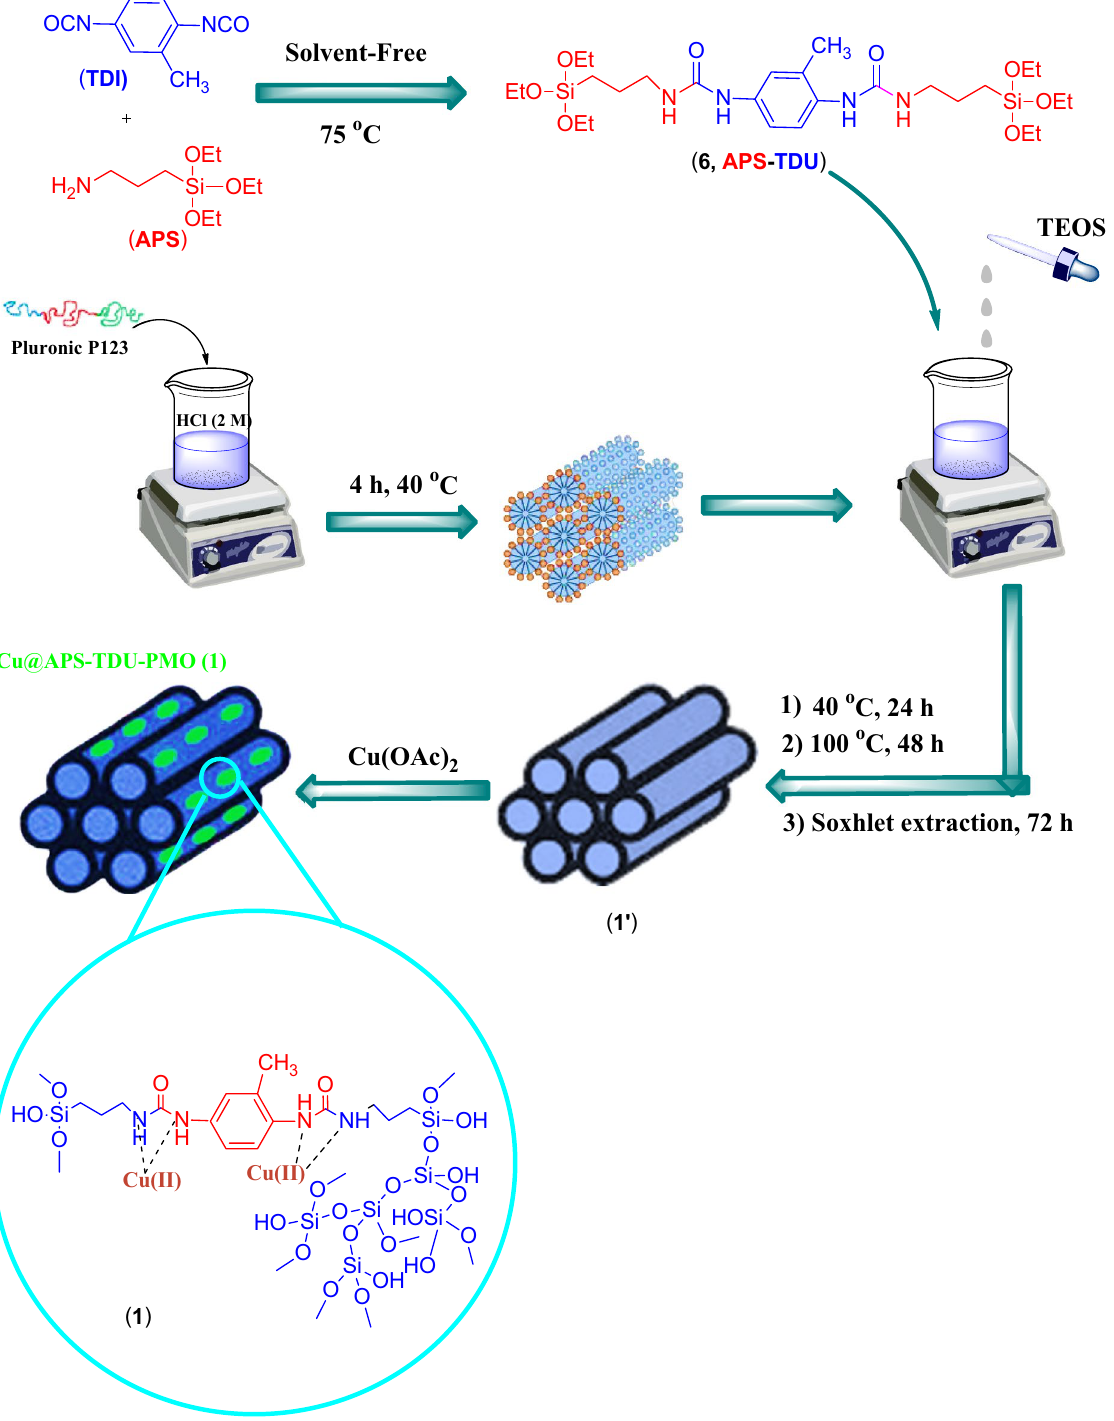
Figure 11. General procedure for the preparation of Cu@APS-TDU-PMO nanocatalyst ( 1